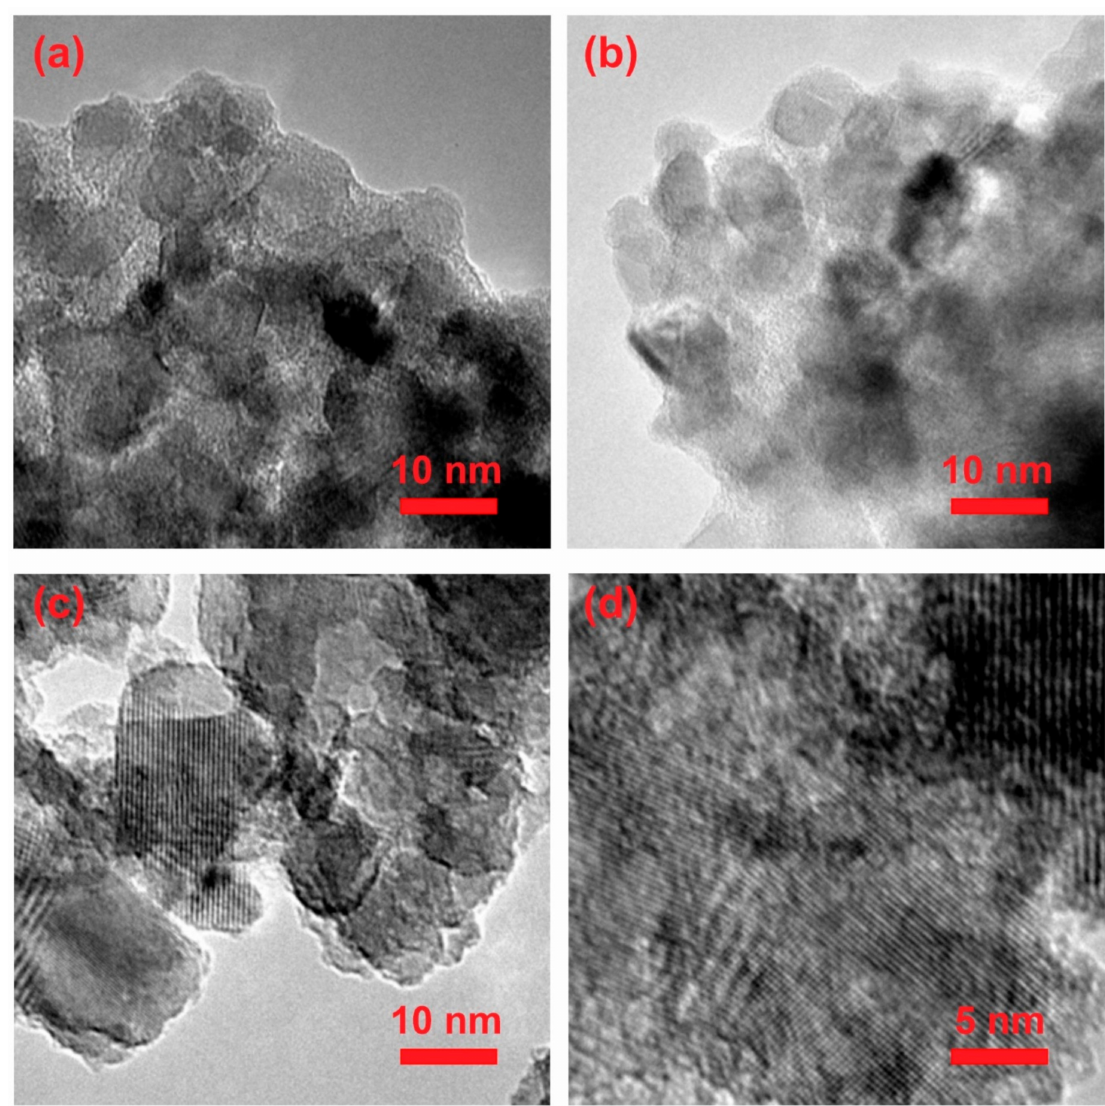
Figure 2. HRTEM pictures of synthesized n-TiO 2 : ( a ) amorphous, ( b ) semicrystalline, ( c , d )